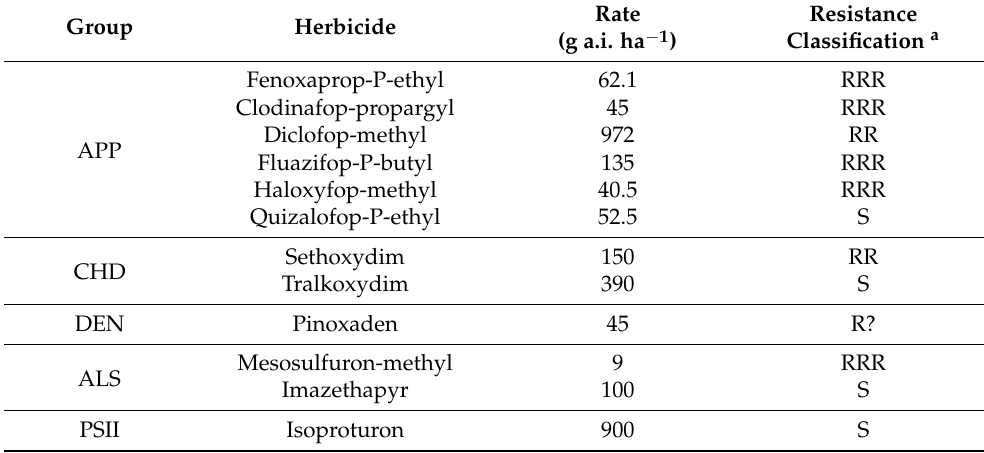
Table 2. The herbicides used in cross-resistance identification and their application